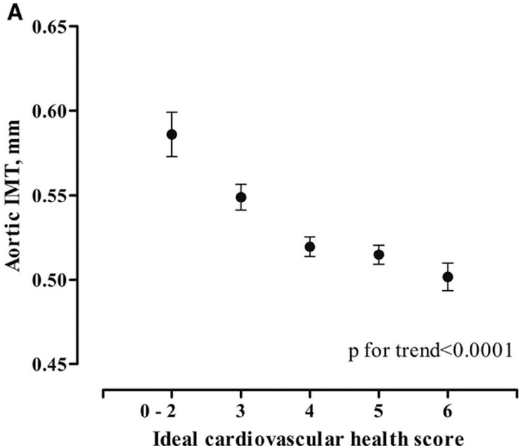
Figure 3. Ideal cardiovascular health in adolescence and abdominal aortic IMT. Ideal cardiovascular